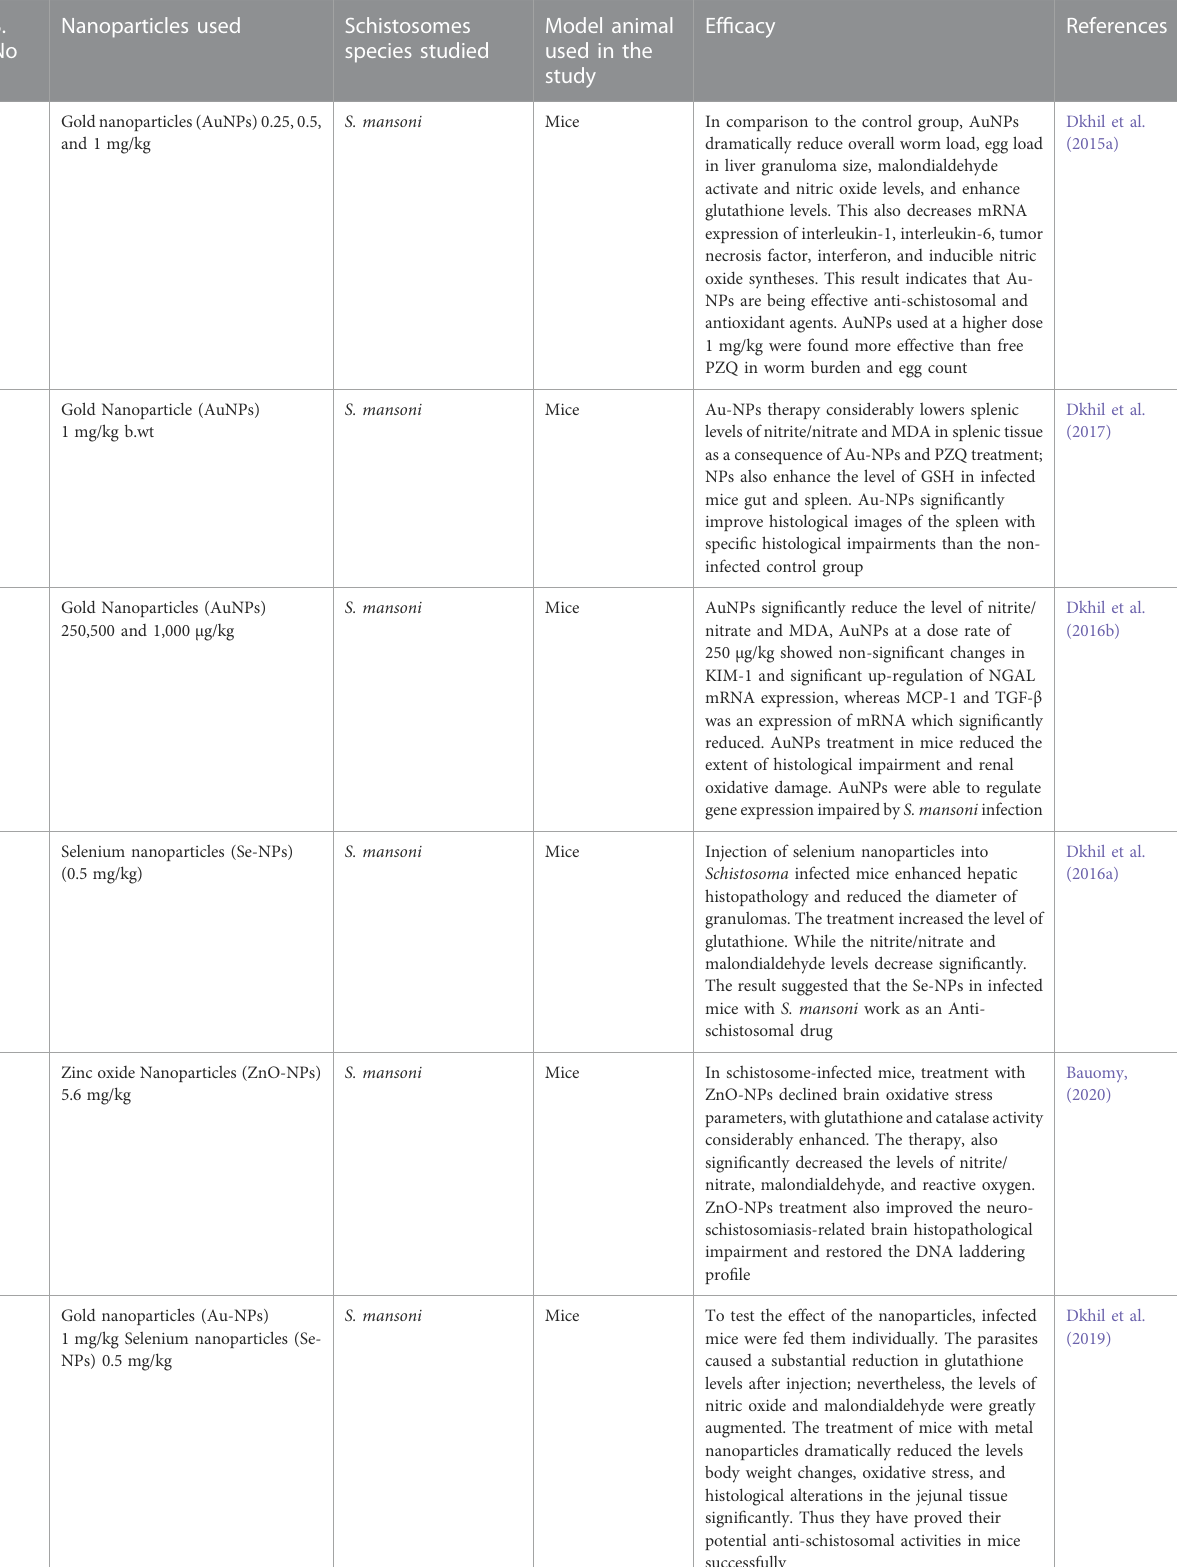
TABLE 2 List of various nanoparticles used therapeutically in the treatment of schistosomal infections. S.